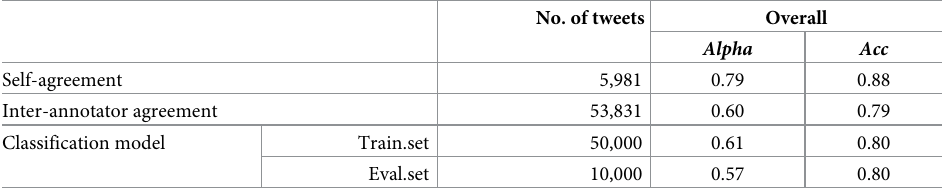
Table 3. The annotator agreement and the overall model performance. Two measures are used: ordinal Krippen- dorff’s Alpha and accuracy ( Acc ). The first line is the self-agreement of individual annotators, and the second line is the inter-annotator agreement between different annotators. The last two lines are the model evaluation results, on the training and the out-of-sample evaluation sets, respectively. Note that the overall model performance is comparable to the inter-annotator agreement.